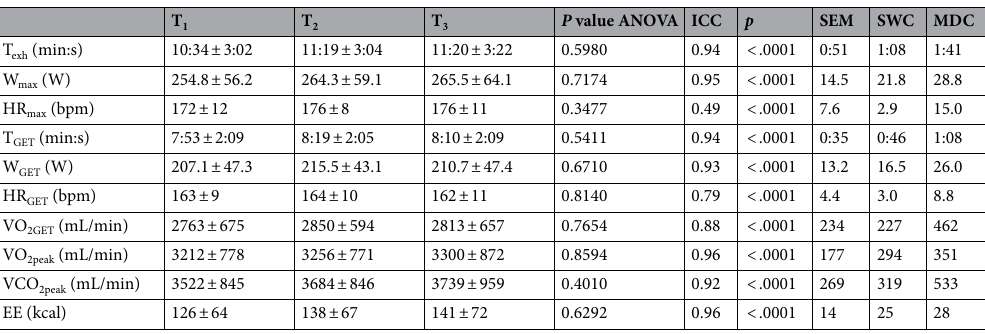
Table 4. Repeatability of aerobic variables measured in incremental cycling test. EE, energy expenditure; HR GET , heart rate at gas exchange threshold; HR max , maximal heart rate; ICC, interclass correlation coefficient; MDC, minimal detectable change; SEM, standard error of measurement; SWC, smallest worthwhile change; T exh , time to exhaustion; T GET , time to gas exchange threshold; VCO 2peak , maximal carbon dioxide production; VO 2peak , peak oxygen uptake; VO 2GET , oxygen uptake at gas exchange threshold; W max , maximal workload; W GET , workload at gas exchange threshold.